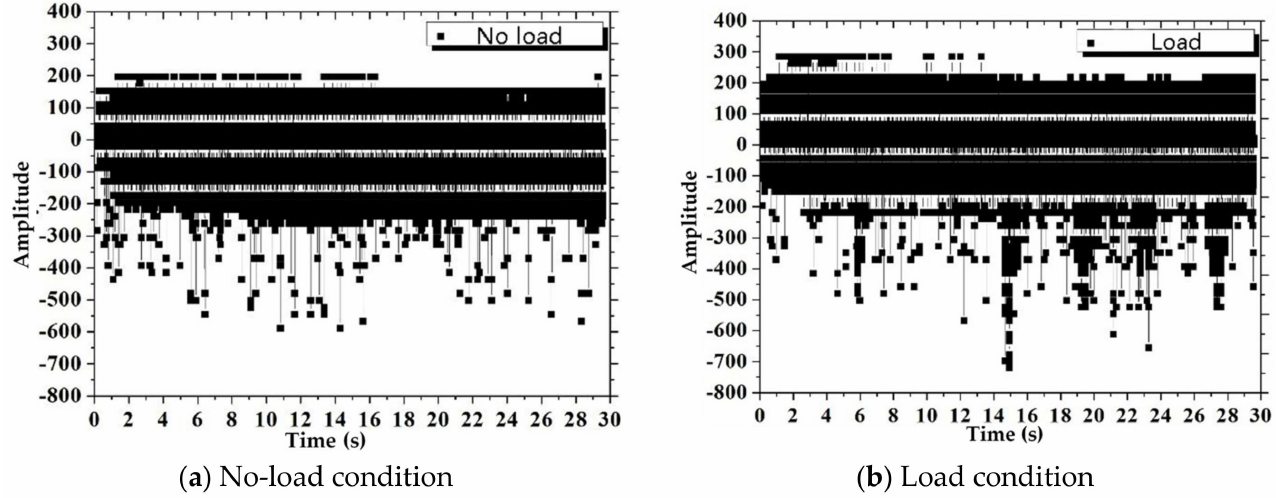
Figure 11. Vibration signals under no-load and load